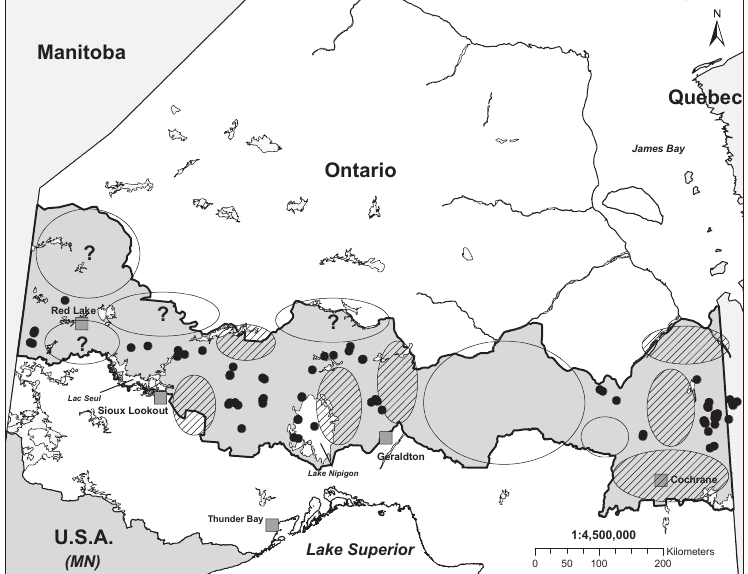
Fig. 2. Approximate deployment locations (black circles) of radio collars placed on forest-dwelling woodland caribou in Ontario from 1995 to 2008. Only deployment locations of individuals included in the cluster analysis ( n = 73) are depicted. The gray polygon is bounded by the southern boundary of the ecotype’s continuous distribution in the province (OMNR 2009) and the approxmate northern extent of historic sampling efforts in the province. The hatched ellipses represent areas where spatial gaps in deployment loca- tions correspond with apparent low density areas for caribou (assessed during winter). Hollow ellipses without question marks represent areas where spatial gaps in deployment locations are known to be artefacts of inadequate sampling efforts. Hollow ellipses with question marks represent areas where further sampling efforts are needed to determine whether spatial gaps in deployment locations reflect low caribou density or whether they are artefacts of inadequate sampling